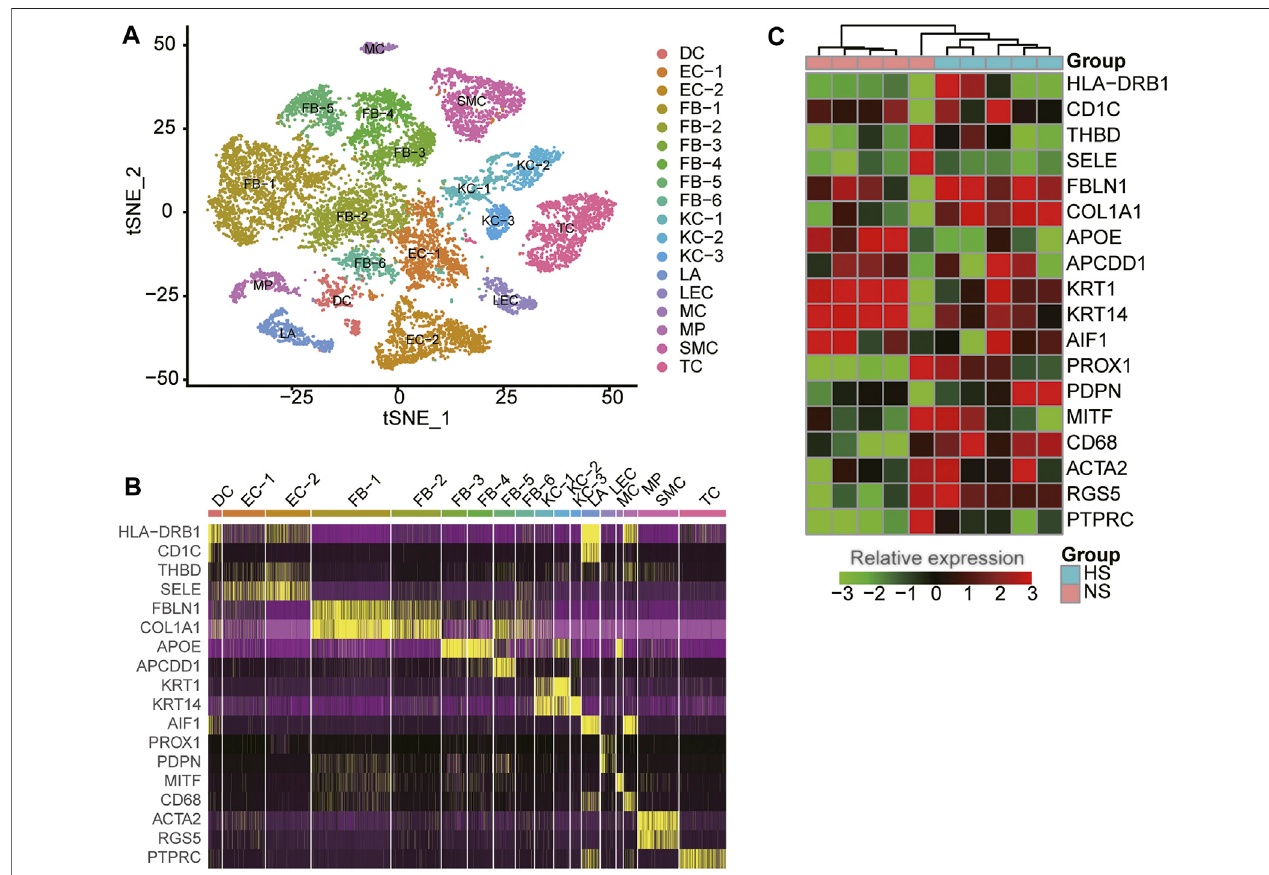
FIGURE 1 | The cell populations and marker genes in the skin samples of hypertrophic scar (HS) and normal skins. (A) The cell clusters visualized by the dimensional reduction of t-distributed stochastic neighbor embedding (t-SNE). Each point represents one cell, and the fi lled colors represent the cell types. (B) The expression speci fi city of cell type-speci fi c marker genes within the skin samples using scRNA-seq data. (C) The differential expression of the cell type-speci fi c marker genes between HS and normal skins using bulk RNA-seq